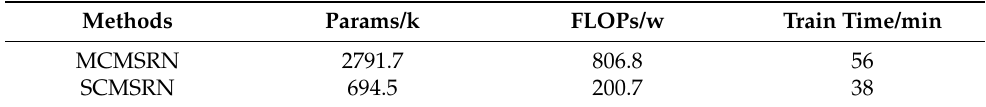
Table 4. Comparison in terms of computational